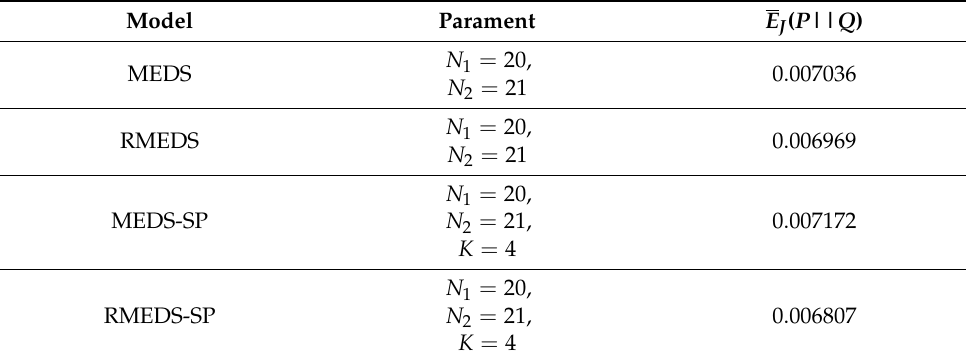
Table 1. PDF’s modeling error of different models’ amplitude